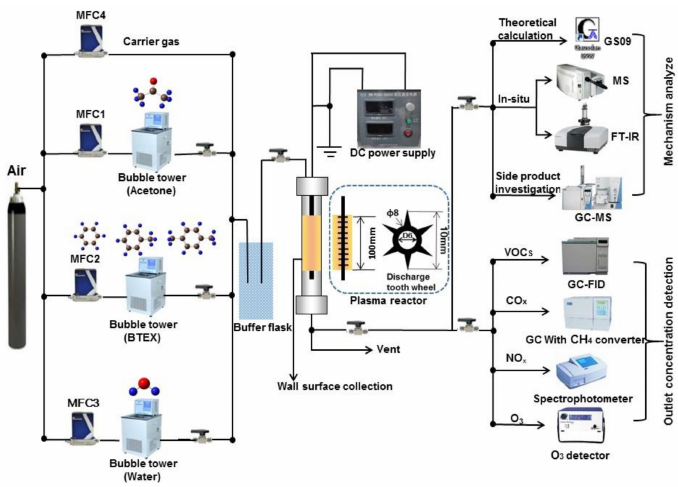
Figure 1. Schematic diagram of the experimental